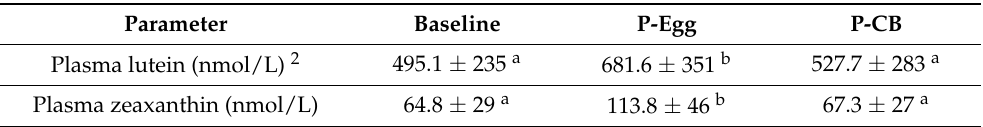
Table 2. Plasma lutein and zeaxanthin in subjects at baseline and post (P) intervention after either egg (P-Egg) or choline bitartrate (P-CB) supplement for 4 weeks 1 .